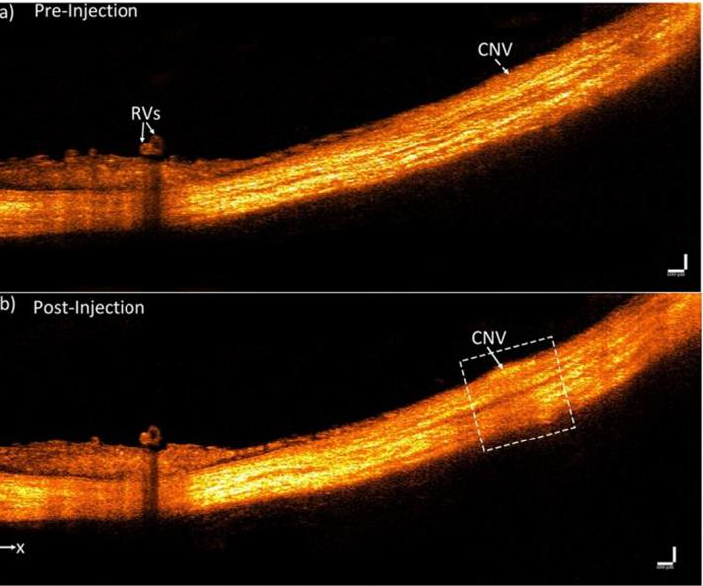
Figure 11. OCT image enhanced with GNS in vivo: B-scan OCT images obtained before ( a ) and 2 h after IV injection of GNS ( b ). The white arrows indicate the position of choroidal neovascularization (CNV) [109].